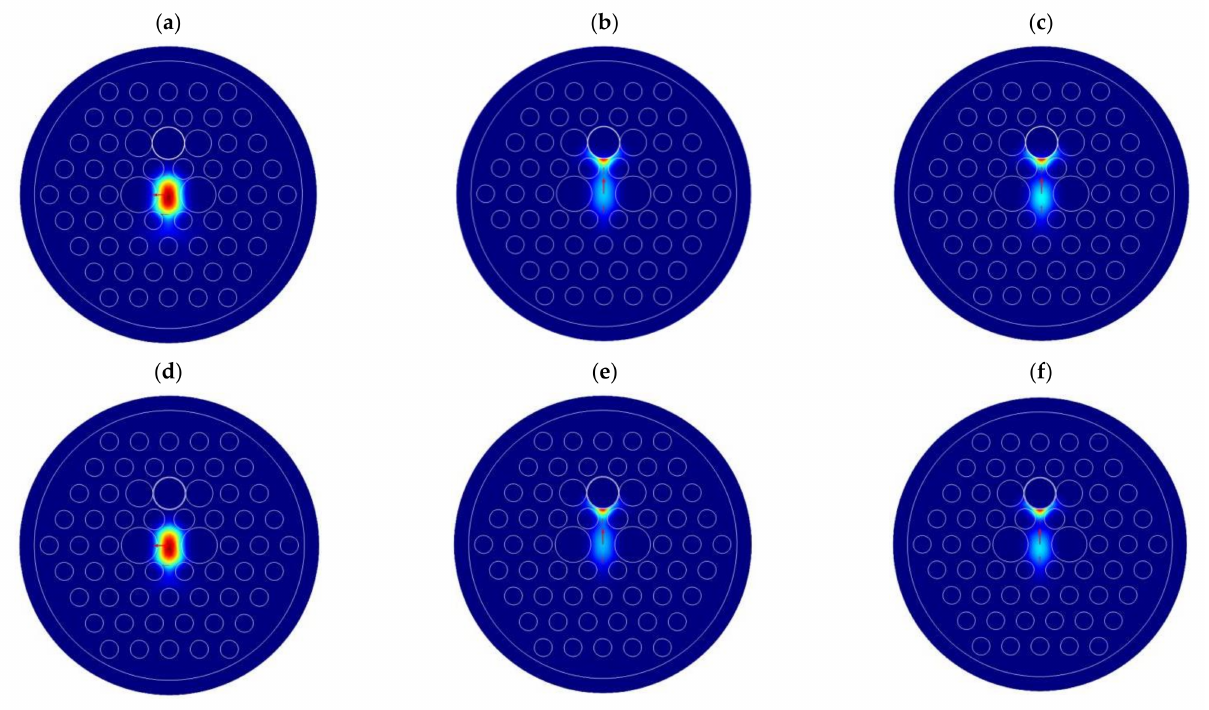
Figure 5. Distribution of the electric field of ( a , d ) X-polarized CM, ( b , e ) Y-polarized CM, and ( c , f ) Y-polarized SPM at 1550 and 1310 nm as the complete coupling